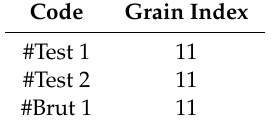
Table 9. Grain index according to ASTM E112-13 [49].